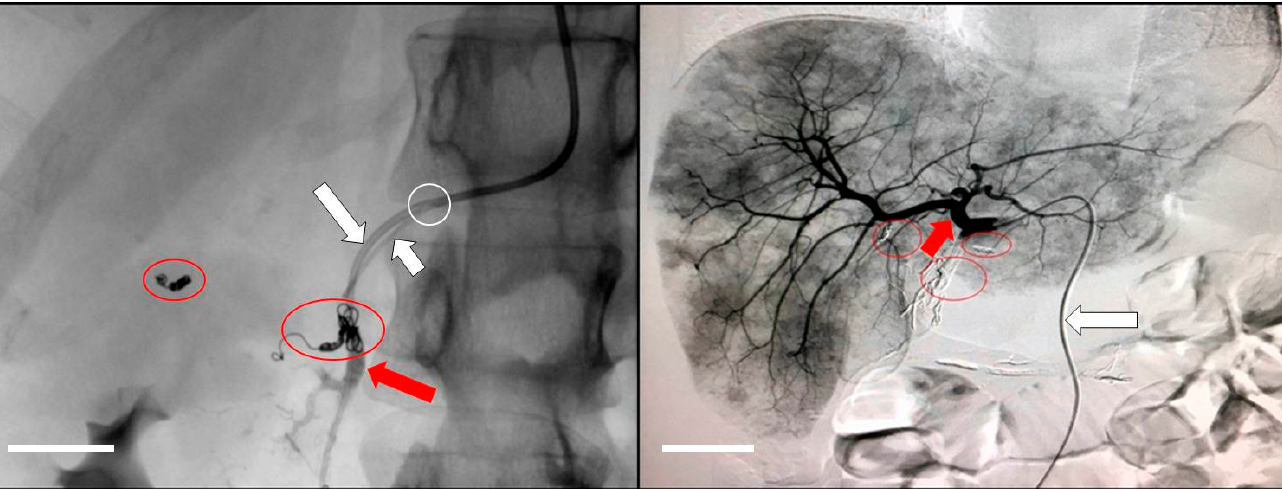
Figure 1. An example of the modification of the liver vascular network to avoid the reflux of cytotoxic drugs into the stomach and duodenum. Red circles indicate embolization by coils and spirals of non-target arterial branches, such as artery cystic, gastric arteries, accessory hepatic arteries, and pancreatic-duodenal arteries. The distal tip of the infusion catheter (big white arrow) is fixed within the gastro-duodenal (big red arrow) by means of vessel embolization. Therefore, the infusion hole of the catheter is facing the proper hepatic artery. The embolic agents are gradually released through a coaxial microcatheter (small white arrow) introduced into the lumen of the catheter up to the infusion hole (white circle). The small red arrow indicates proper hepatic artery at the origin of its branches. Scale bar equals 1 cm.